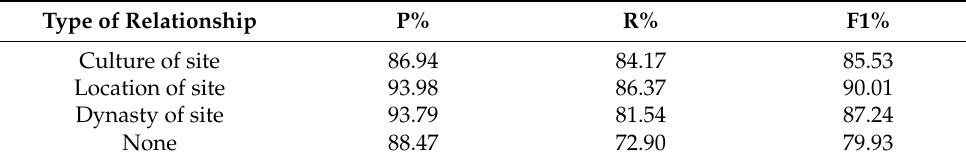
Table 9. Experimental results of the BiGRU-Dual Attention